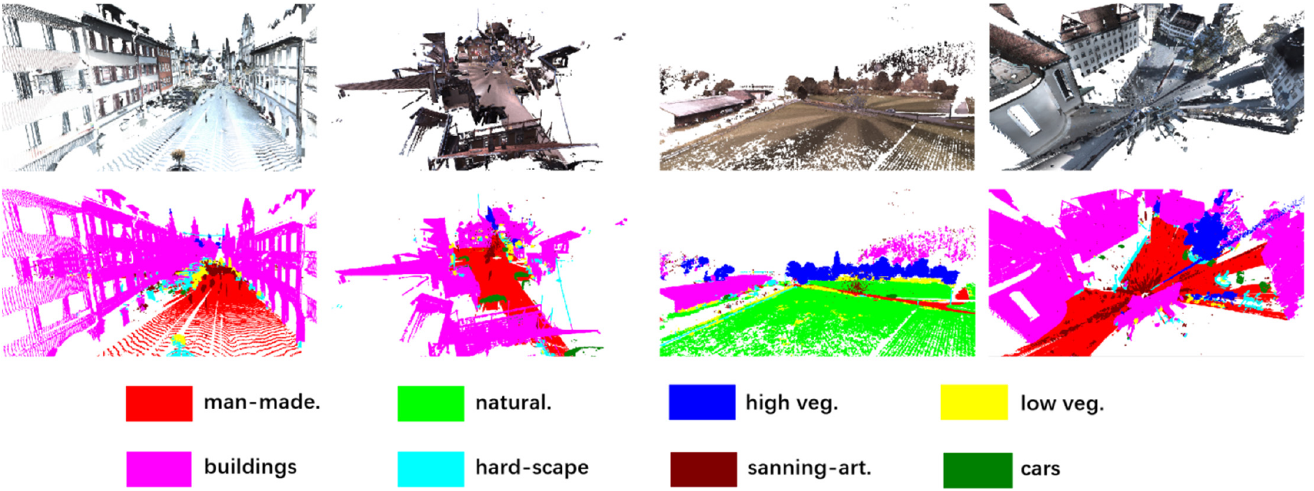
Figure 9. The visualization results of Semantic3D (reduced − 8). Table 3. The quantitative results (%) of SemanticKITTI (single-scan).